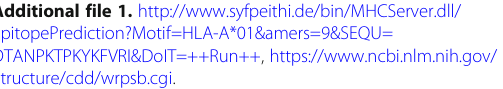
minal. The position with a potential (the green vertical lines) crossing the threshold (red horizontal line) is pre- dicted glycosylated.